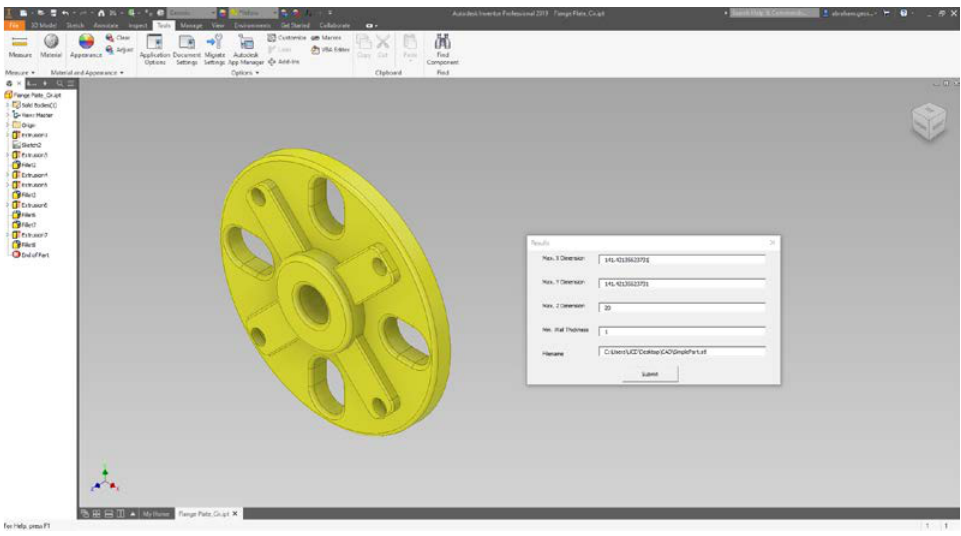
Figure 10. Test Case 2—Part geometry analysis tool integrated with a commercial CAD system.